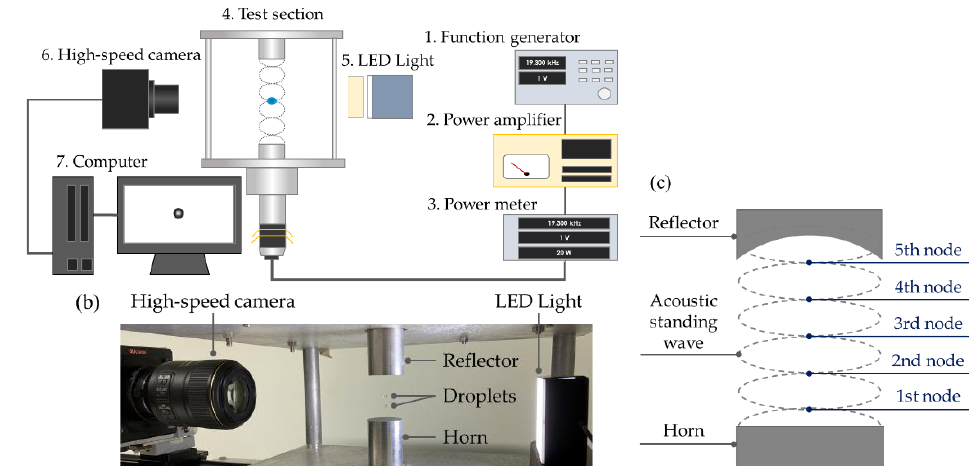
Figure 1. Experimental setup. ( a ) Schematic and ( b ) photograph of acoustic levitation and observa- tion system. ( c ) Acoustic standing wave between the horn (sound emitter) and reflector with five pressure nodes.